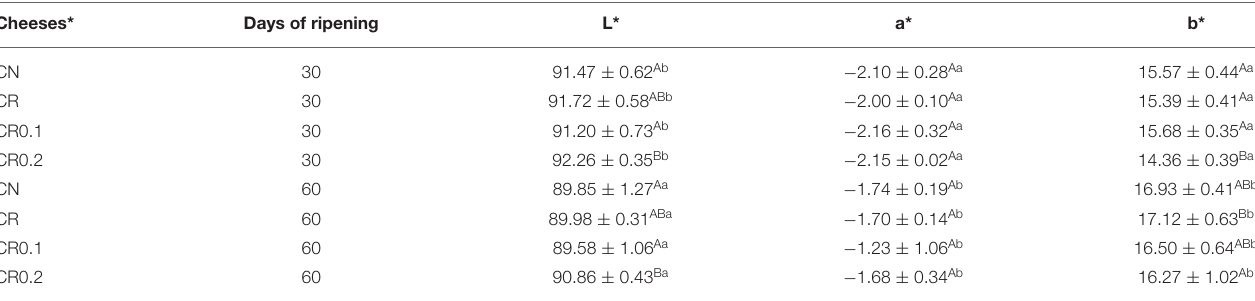
TABLE 7 | Color results of reduced-sodium cheeses by reduced-sodium treatment (CR) at 30 and 60 days of ripening. Cheeses* Days of